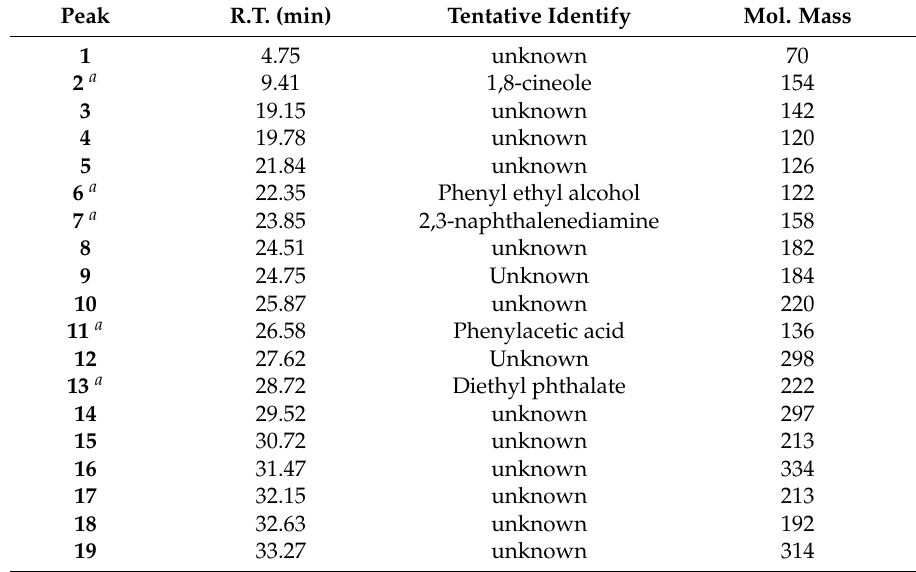
Table 2. A GC/MS analysis of the VOCs produced by